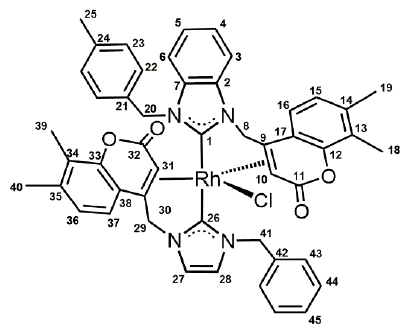
Figure 5. Numbering of atoms for complex 6 . Preparation of RhCl( κ C , η 2 -BzICou Bu )(IPr) (7). (Figure 6) A mixture of RhCl